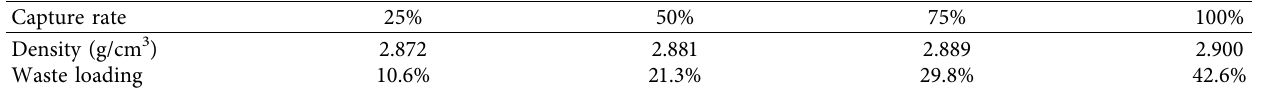
Figure 1: Schematic of nuclide management process and major nuclides generated from each Table 1: Densities and waste loadings of Cs waste/waste form according to capture rate of Cs nuclide.